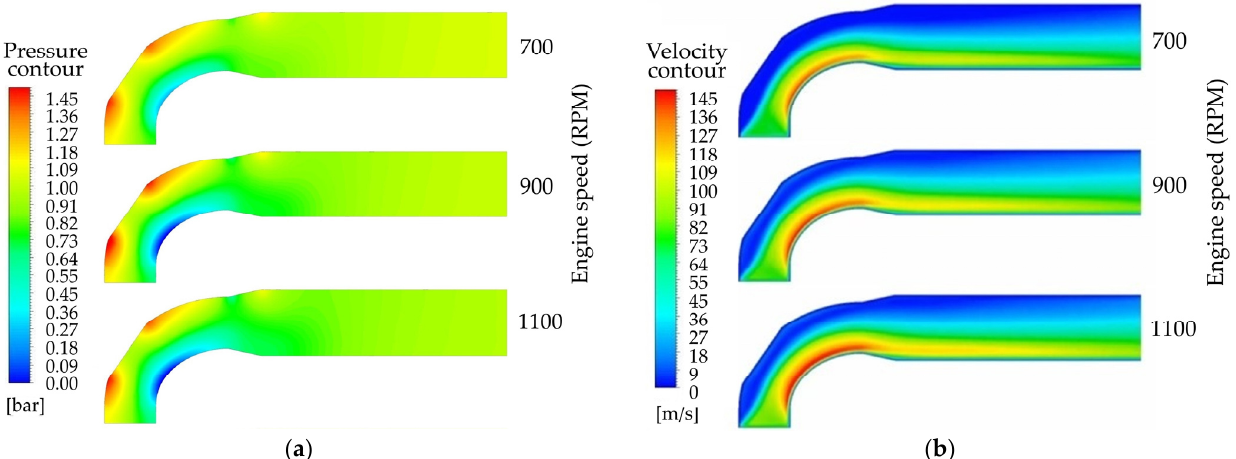
Figure 6. Contour results of exhaust port in the 3D zone at exhaust valve fully opened (254 CA°): ( a ) Pressure contours; ( b ) velocity contours.